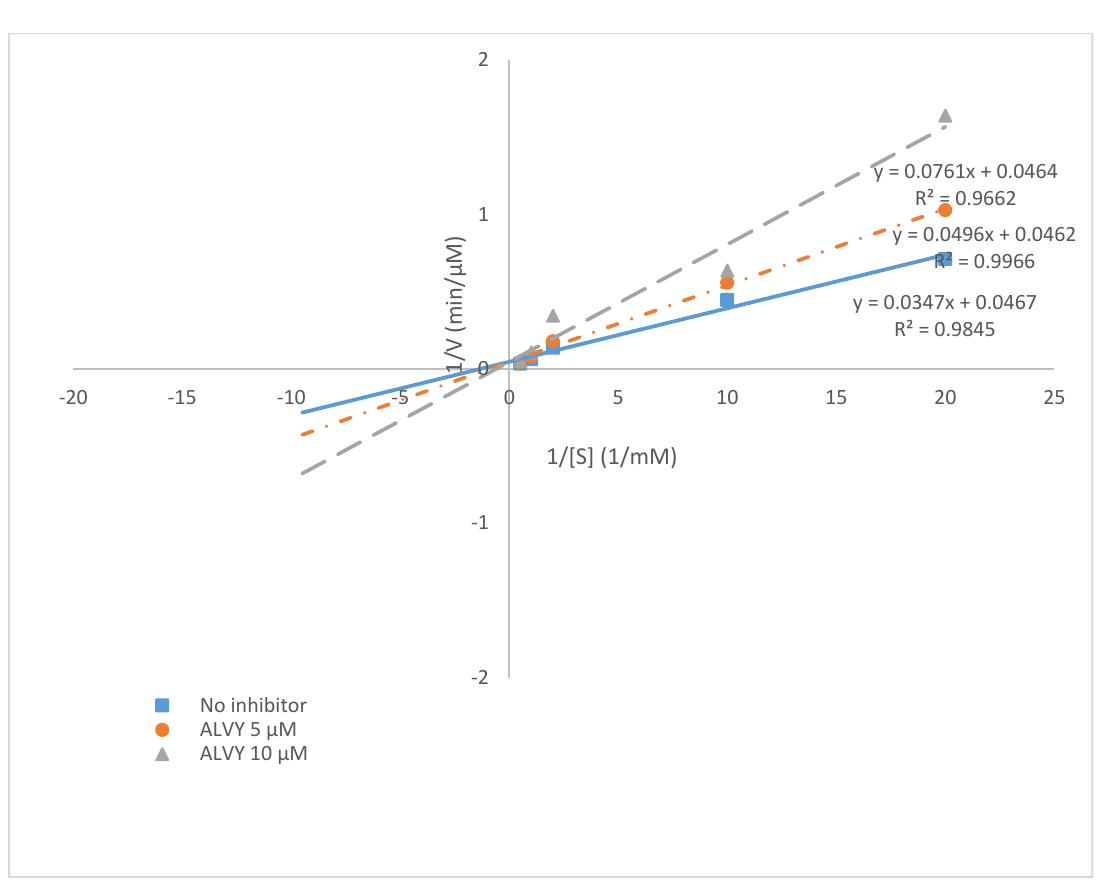
Figure 7. Lineweaver-Burk plot of ACE inhibitory by ALVY.